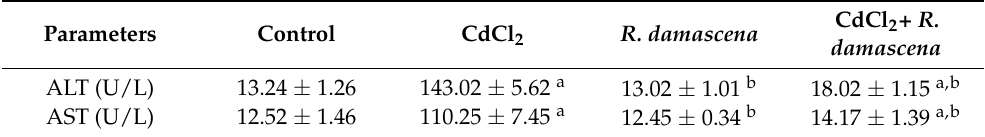
Table 4. Effects of R. damascena methanolic extract (100 mg Kg − 1 ) on liver enzymes in CdCl 2 (5 mg Table 3. Retention time (RT) and peak area (%) of Rosa damascena extract ’s main constit- Kg − 1 )-treated uents.